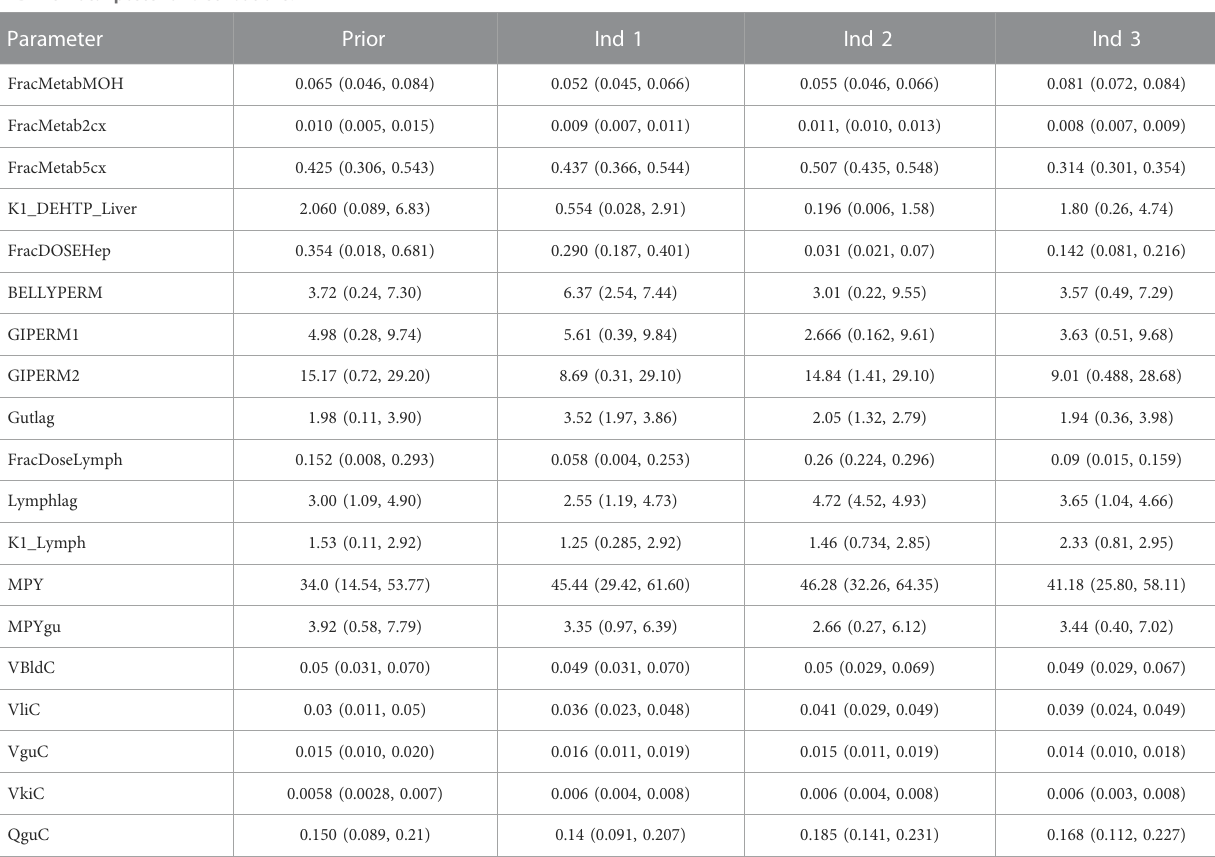
TABLE 5 Local posterior distributions. Parameter